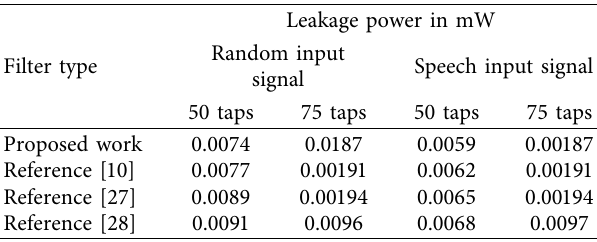
Table 1: Comparison of leakage power conception of the con- ventional and proposed FIR filters.